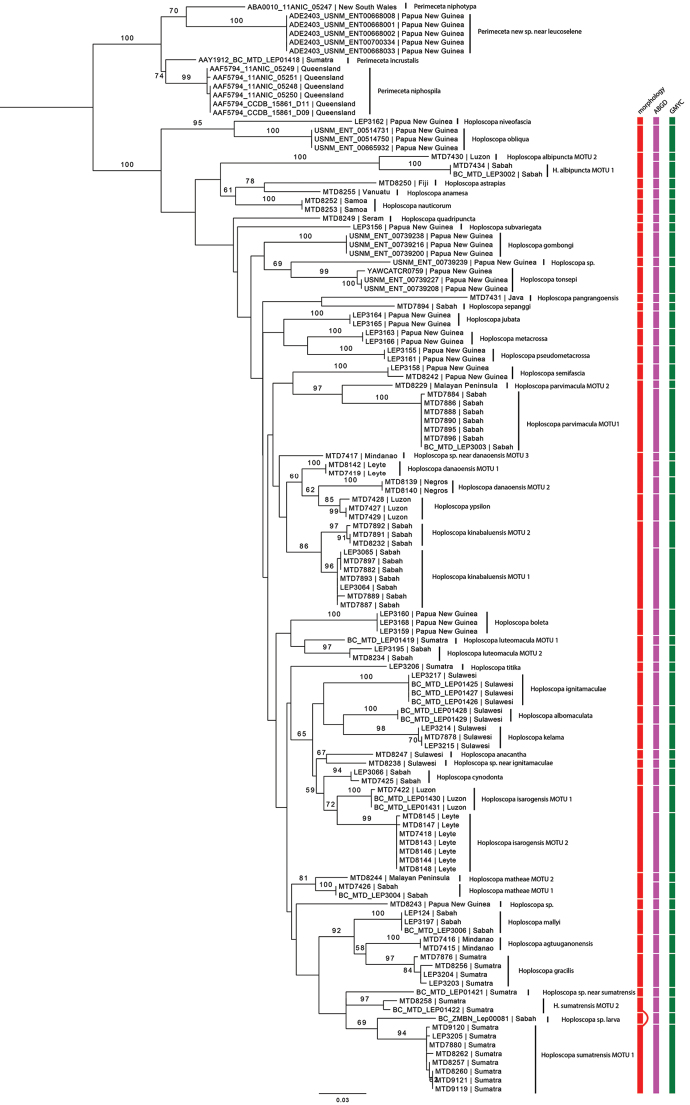
RaxML analysis of the COI barcode dataset partitionned after codon positions. Node support estimated with 1000 thorough bootstrap replicates using the GTR+GAMMA substitution model. Columns on the right display species delimitation inferred from the morphology (red), the ABGD (pink), and GMYC (green) methods.